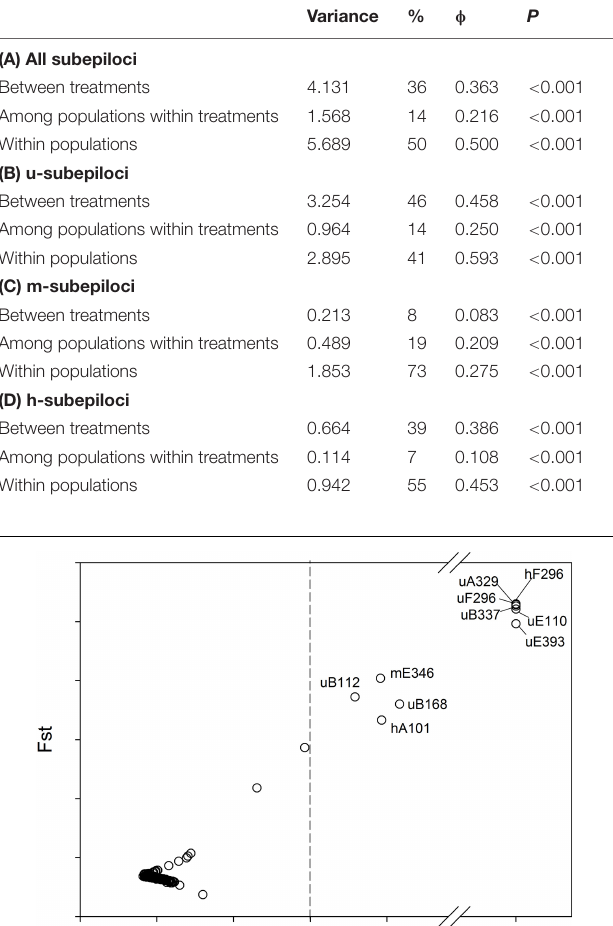
TABLE 2 | Results of hierarchical AMOVA based on (A) all subepiloci and (B) u-, (C) m-, and (D) h-subepiloci of MSAP. Variance % φ